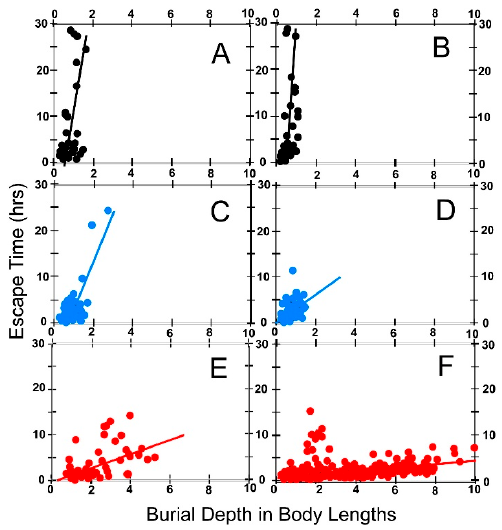
Figure 14. Escape times for the three test species plotted as a function of body length. Escape time is defined as in Figure 13. Burial depth in body lengths is the distance between the uppermost point on the shell of the anastrophically buried animal and the new sediment-water interface expressed in body lengths as defined in the text (i.e. body length = shell length). Each point plotted on the graphs represents the escape time for a single animal buried at the indicated depth. ( A , B ) Pyganodon cataracta ; ( C , D ) Elliptio complanata ; ( E , F ) Corbicula fluminea; ( A , C , E ): Burial in coarse sand (0 Φ ≥ grain size ≥ 1 Φ ); ( B , D , F ): Burial in fine sand (2 Φ ≥ grain size ≥ 3 Φ ). Best fit linear regressions shown in red for each data set. ( A ): Y = 10.586X − 1.976 (corr coef = 0.414); ( B ): Y = 11.537X − 2.602 (corr coef =